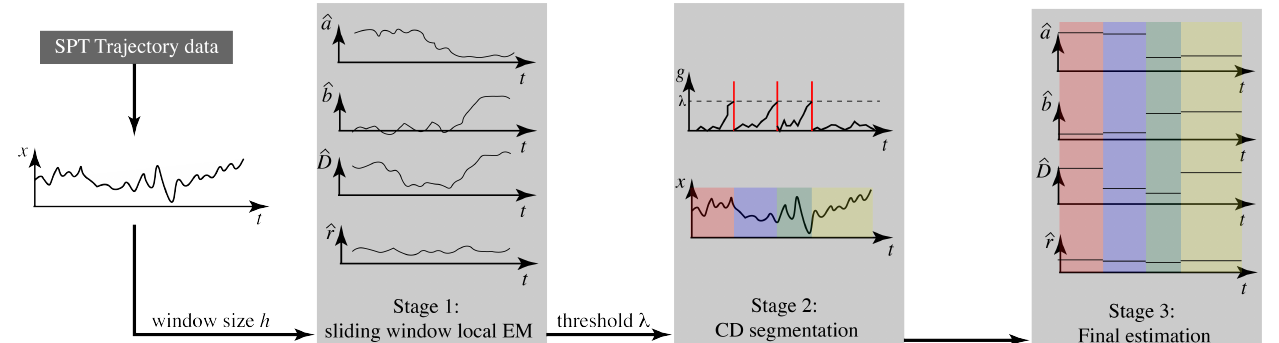
Figure 1. Overview of the three-stage algorithm for estimating parameters of a linear motion model that switches values at discrete